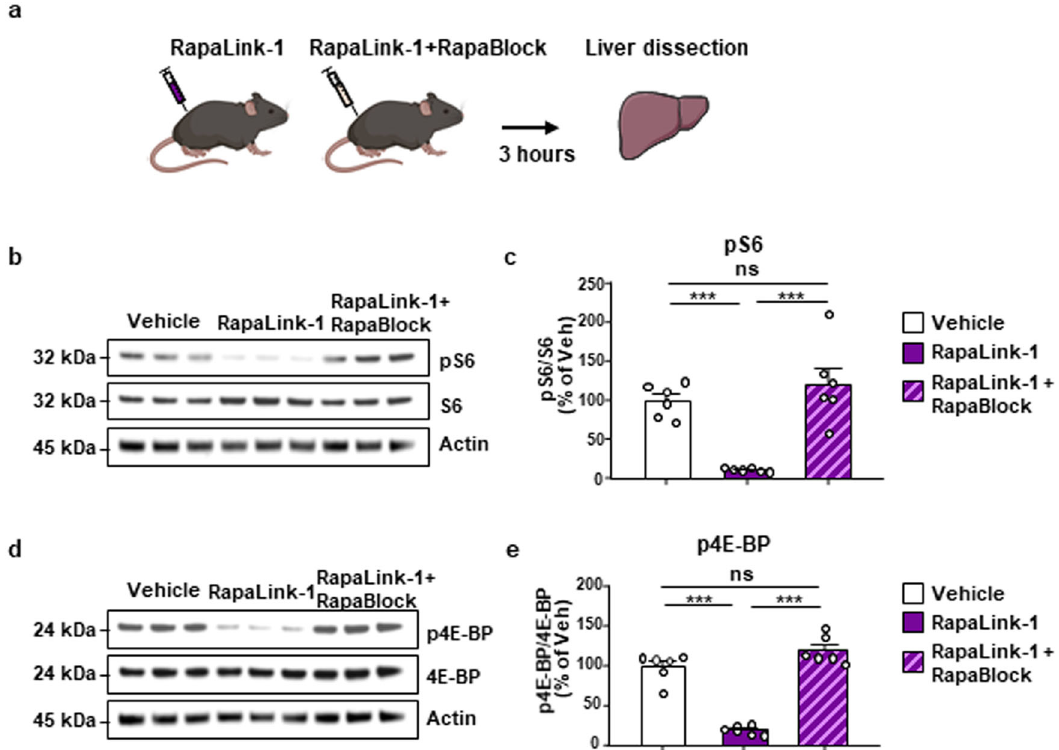
Fig. 2 RapaBlock protects mTORC1 activity in the liver. a Timeline of the experiment. Mice received a systemic administration of vehicle (white), RapaLink-1 alone (1 mg/kg, purple) or a combination of RapaLink-1 (1 mg/kg, purple) and RapaBlock (40 mg/kg, pink), and mTORC1 activity in the liver was measured 3 h later. b , d Representative images depict S6 phosphorylation (pS6) b and 4E-BP phosphorylation (p4E-BP) d (top panels), total protein levels of S6 b and 4E-BP d (middle panels), and actin b , d (bottom panels), which was used as a loading control. c , e Data are presented as the individual data points and mean densitometry values of the phosphorylated protein divided by the densitometry values of the total protein ± SEM and expressed as % of vehicle. Signi fi cance was determined using One-way ANOVA followed by Tukey ’ s multiple comparisons test. RapaBlock protects mTORC1 activity in the liver. pS6 (One-way ANOVA: F 2,15 = 20.56, p < 0.0001, r 2 = 0.7327; vehicle vs. RapaLink-1 p = 0.0006, vehicle vs. RapaLink-1 + RapaBlock p = 0.4796, RapaLink-1 vs. RapaLink-1 + RapaBlock p < 0.0001). p4E-BP (one-way ANOVA: F 2,15 = 42.77, p < 0.0001, r 2 = 0.9101; vehicle vs. RapaLink-1 p < 0.0001, vehicle vs. RapaLink-1 + RapaBlock p = 0.0713, RapaLink-1 vs. RapaLink-1 + RapaBlock p < 0.0001). n = 6 per condition. *** p < 0.001, ns = non-signi fi